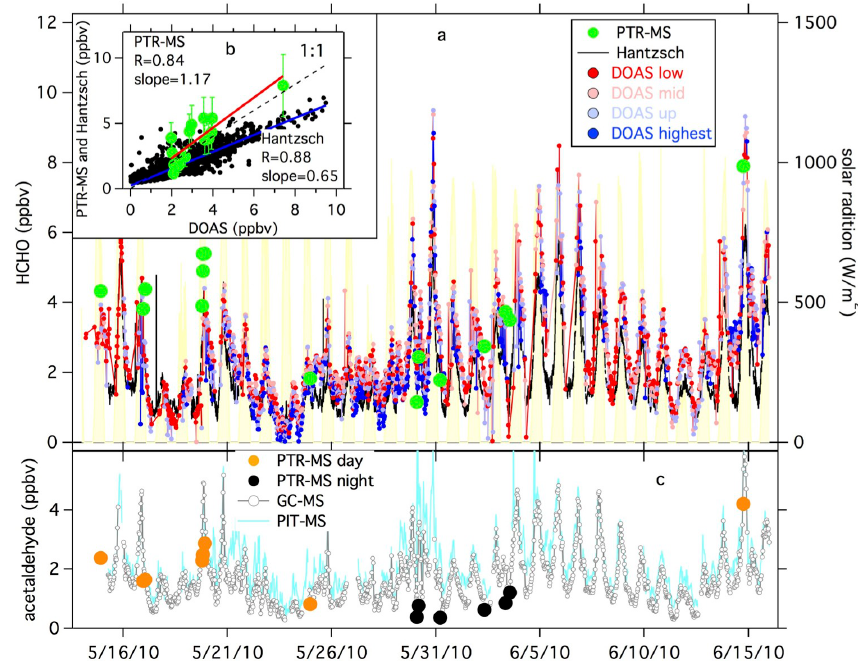
Fig. 8. (a) Inter-comparison of the airborne PTR-MS HCHO with measurements using a DOAS and a Hantzsch monitor at the Pasadena ground site. (b) Scatter plot of the PTR-MS and the Hantzsch versus the DOAS HCHO measurements. Error bars of the PTR-MS measure- ments are the accuracy of each data point. (c) Inter-comparison of the airborne PTR-MS acetaldehyde with measurements using a GC-MS and a PIT-MS on the Pasadena ground site. The color code of the aircraft data indicates the day- and nighttime